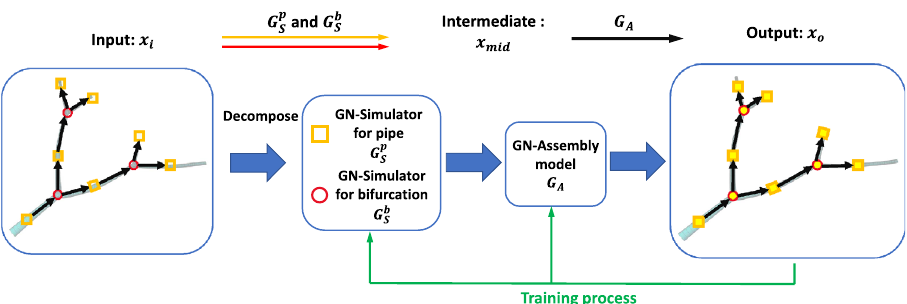
Figure 1. An overview of the GNN model to learn and predict neuron material transport process. The input neurite network is first decomposed into pipes and bifurcations to create the graph representation of the neurite network. Next, the input features x i of each pipe or bifurcation are processed by the corresponding GNN p G b x mid . Then, the GNN assembly model ( G A ) simulator ( G S or S ) to generate intermediate concentration result takes x mid as input and computes the interaction between simulators to predict concentration result x o